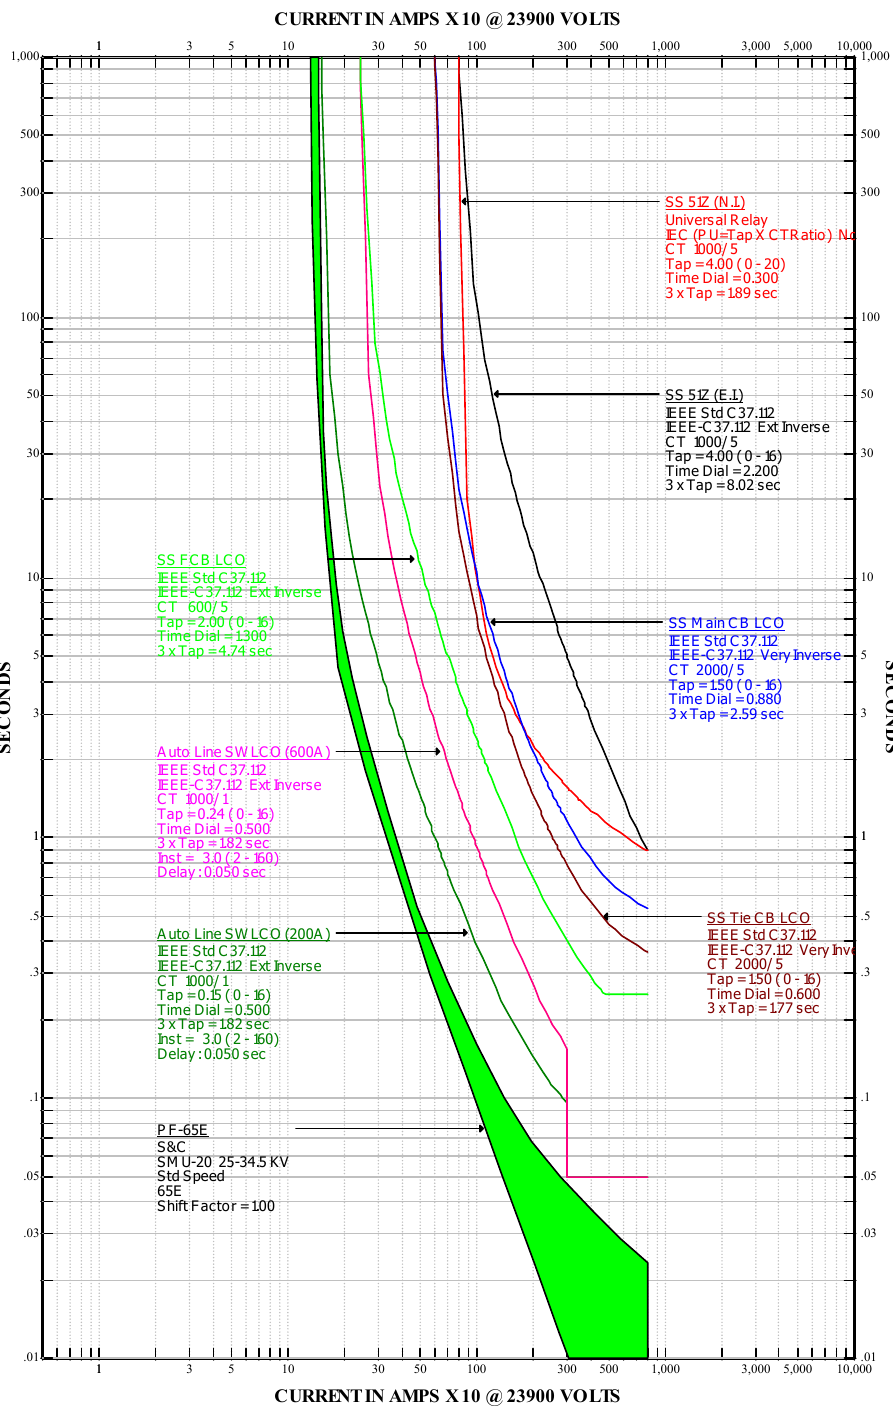
Figure 14. Proposed LCO relays of Fuyuan